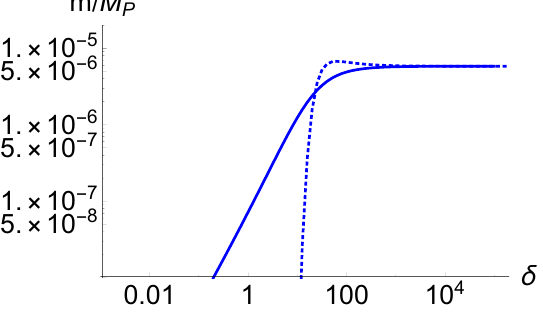
Figure 5. Inflaton mass m vs. δ with N e = 60 e -folds for the CW potential (2.10). Blue dotted line represents inflation in region 2) and blue continuous in region